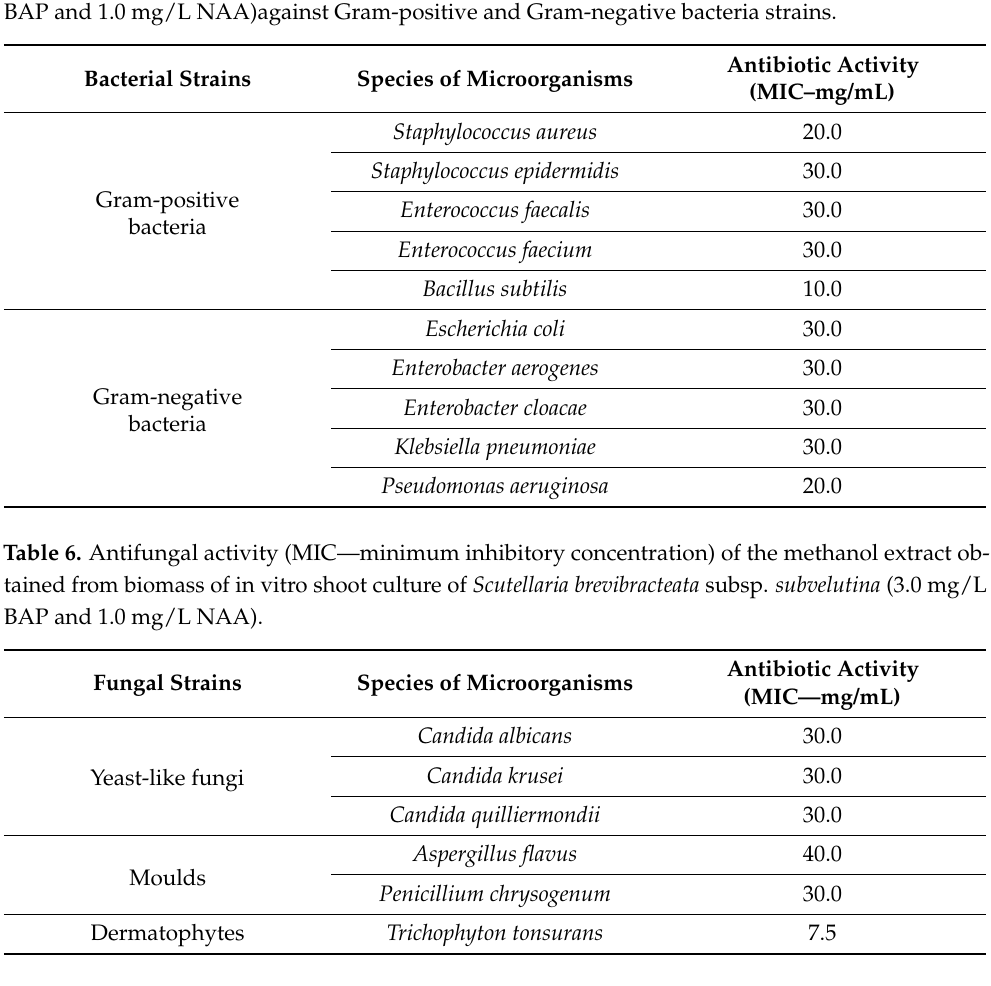
Table 5. Antibacterial activity (MIC—minimum inhibitory concentration) of the methanol extract ob- tained from biomass of in vitro shoot culture of Scutellaria brevibracteata subsp. subvelutina (3.0 mg/L